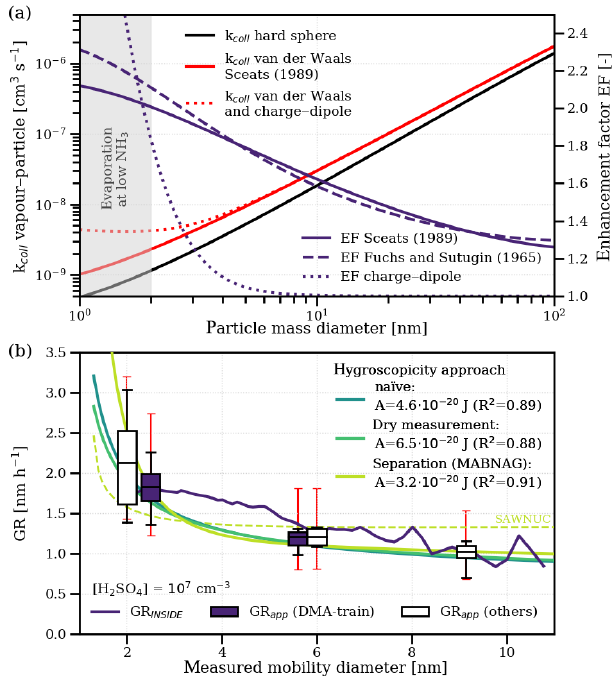
Figure 4. The size dependence of sulfuric acid growth. Panel (a) shows the theoretical collision rate of hydrated sulfuric + 2 M acid vapour molecules ( m v = M H H 2 O ) with particles of 2 SO 4 a certain mass diameter. The black line represents the hard-sphere limit, the red solid line also includes a collision enhancement due to van der Waals forces based on the approach of Sceats (1989; A = 4 . 6 × 10 − 20 J), and the red dashed line is based on the approach of Fuchs and Sutugin (1965; A = 8 . 7 × 10 − 20 J). The red dotted line additionally includes charge–dipole interactions based on av- erage dipole orientation theory. The blue lines show the enhance- ment factor of a single attractive force compared to the hard-sphere limit. Panel (b) shows the measured size dependence of growth rates normalized to a sulfuric acid concentration of 10 7 cm − 3 . The solid blue line shows the growth rates inferred using the INSIDE method. Filled boxes represent the appearance time growth rates from the DMA-train used to fit the Hamaker constant. Empty boxes represent the appearance time growth rates from other instruments, includ- ing the results from Lehtipalo et al. (2016) with high ( > 100pptv) NH 3 concentrations. The boxes indicate the median and the 50% interquartile range of the data, whereas the whiskers represent the 90% quantile. The small red error bars indicate the − 33%/ + 50% systematic uncertainty in the sulfuric acid measurement. We show the size dependence of three different approaches for particle hy- groscopicity: the naïve approach (solid turquoise line), assuming the same hydration for vapour and particle; the dry measurement approach (solid light green line), assuming that the DMA-train mea- sures completely dehydrated particles; and the separation approach (solid yellow line), assuming that available composition data from MABNAG can disentangle water uptake from sulfuric acid conden- sation. The separation approach using SAWNUC composition data is also shown as a dashed yellow